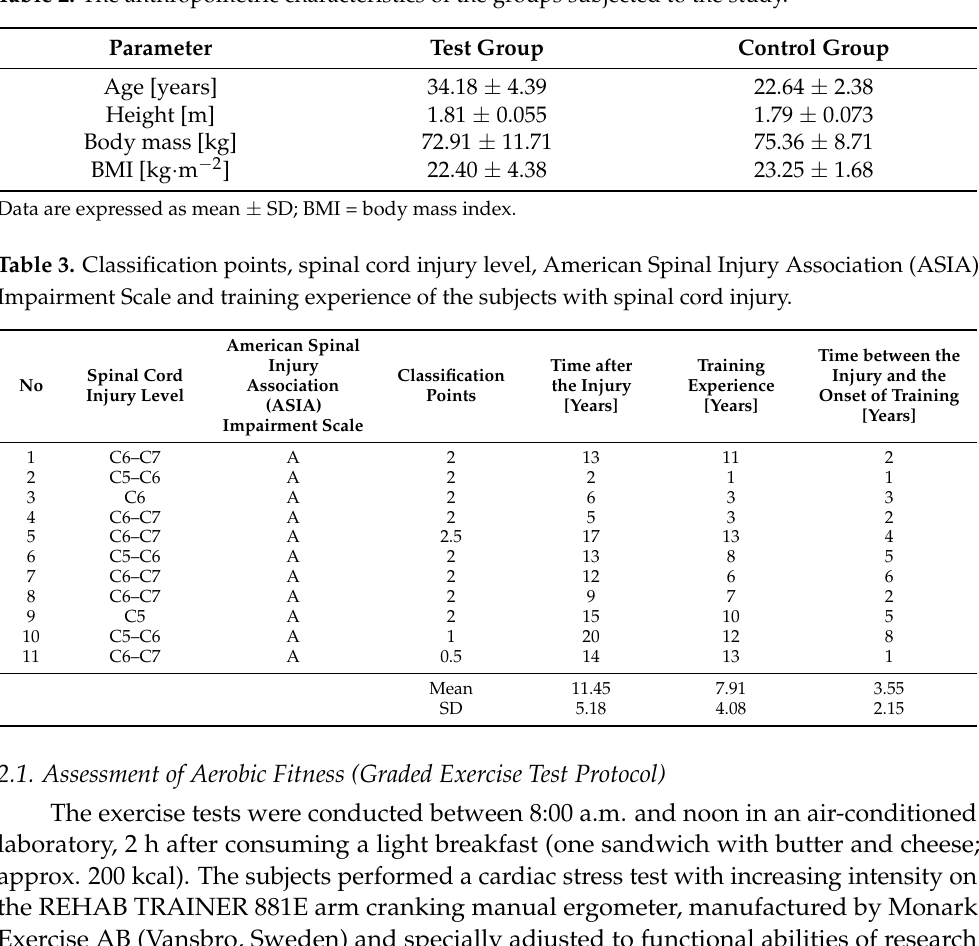
Table 2. The anthropometric characteristics of the groups subjected to the study.